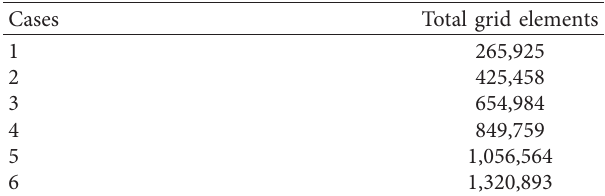
Table 3: Cases of grid elements.